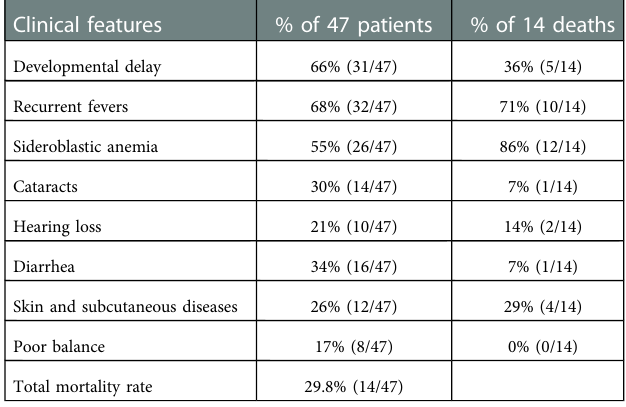
TABLE 3 Clinical features in patients with TRNT1 mutations. Clinical features